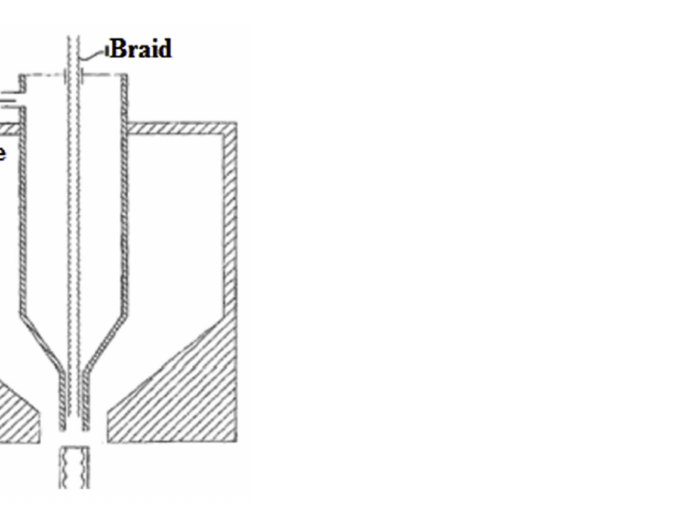
Figure 21. Nozzle design for BRHF membrane production [15]. Reprinted/adapted with permission from Ref. [15]. Copyright 2022, Elsevier.